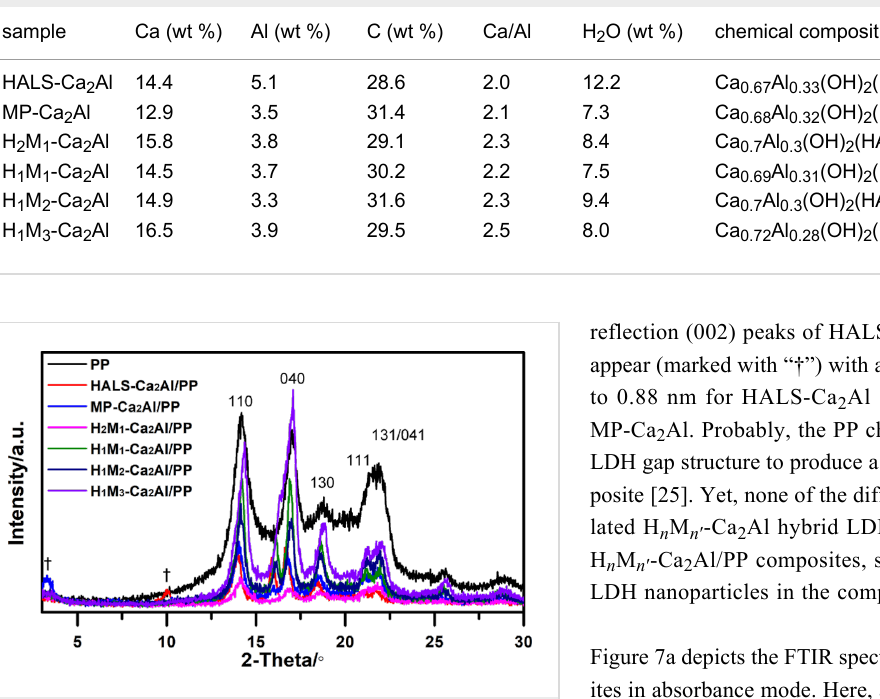
Figure 6: Powder X-ray diffraction pattern of H n M n ′ -Ca 2 Al/PP compos- ites. LDH reflection peaks were marked with “†”.